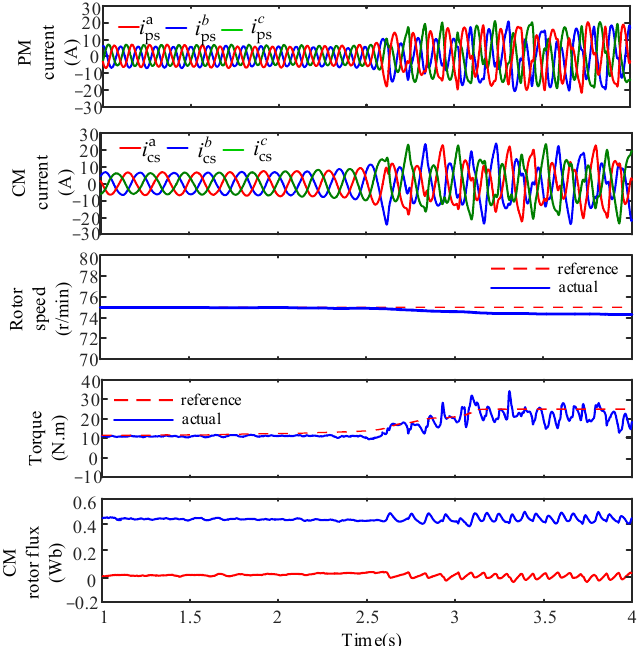
Figure 22. Experimental results of load boundary verification.